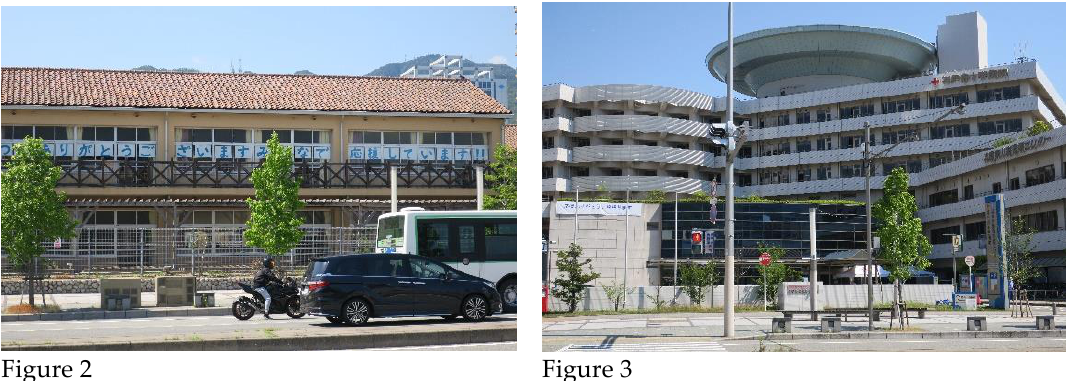
Figures 2 and 3: Words of gratitude and support from elementary school pupils for the staff of the hospital across the street, with a reponse at the front door of the hospital across the street (Kobe, Japan May, 2020 Photo courtesy of